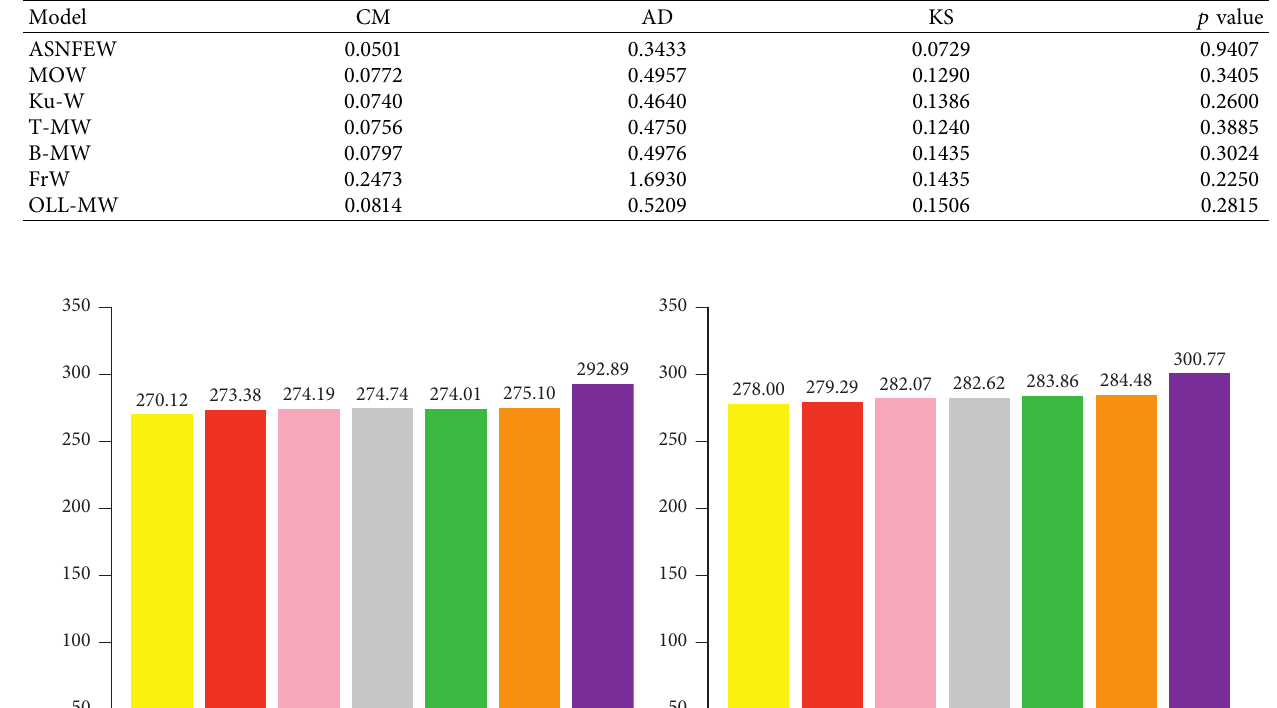
Table 6: Goodness-of-fit measures of the competing models corresponding to COVID-19 data.